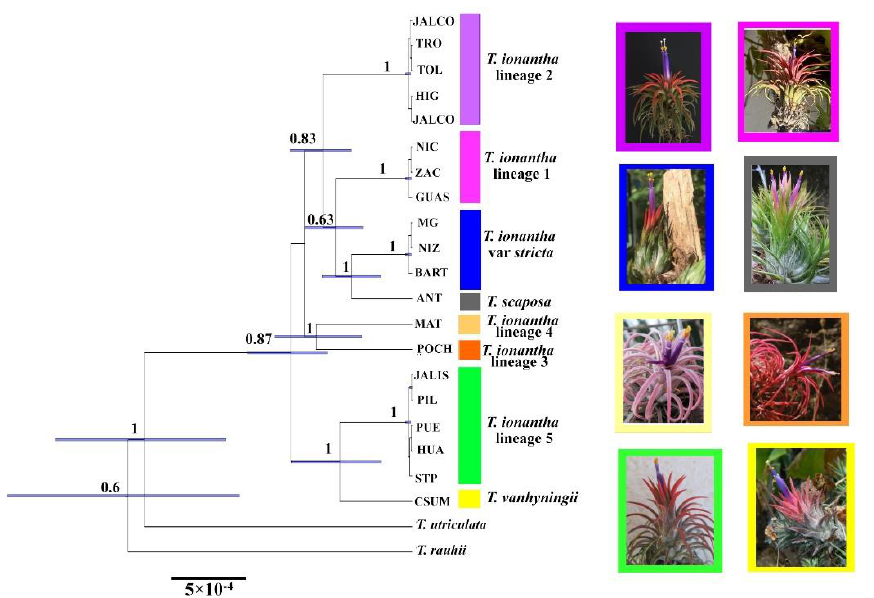
Figure 5. Maximum clade credibility tree of the Tillandsia ionantha species aggregate, along with outgroup taxa, resulting from the multilocus coalescent analyses in STACEY (Beast2). Values above branches are posterior probabilities of clade support. The colors of the perimeter of the photographs correspond to the colors of each of the evolutionary lineages of the minimal clusters tree.